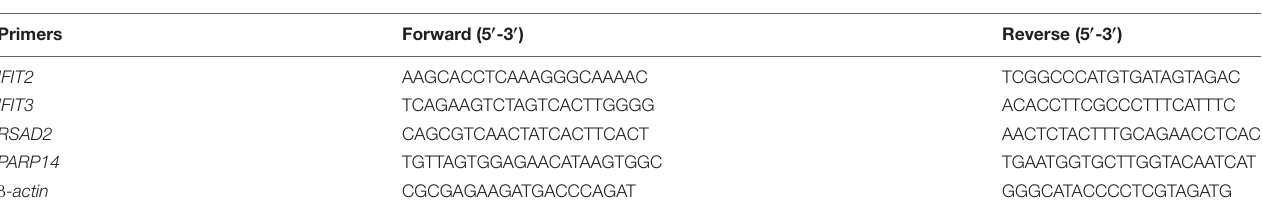
FIGURE 1 | Overall study design. We identified the clinical traits related key modules in GSE33463 by weighted gene co-expression network analysis (WGCNA). Then, we identified 60 hub-genes in the saddlebrown and purple module through the protein-protein interactions (PPI) network. Then, we determined the overlapped four genes between 30 hub-genes and differently expressed genes (DEGs) in GSE19617. Univariate logistic regression (ULR) and multivariate logistic regression (MLR) analysis were utilized to determine independent risk factors for systemic sclerosis-related pulmonary arterial hypertension (SSc-PAH). Through the receiver operating characteristic curve (ROC) analysis, we evaluated the diagnostic capacity of these genes in the GSE19617 and validation cohort. At last, we predicted the potential mechanisms of SSc-PAH by using the Kyoto Encyclopedia of Genes and Genomes (KEGG) pathway and Gene Ontology (GO). TABLE 1 | The primers